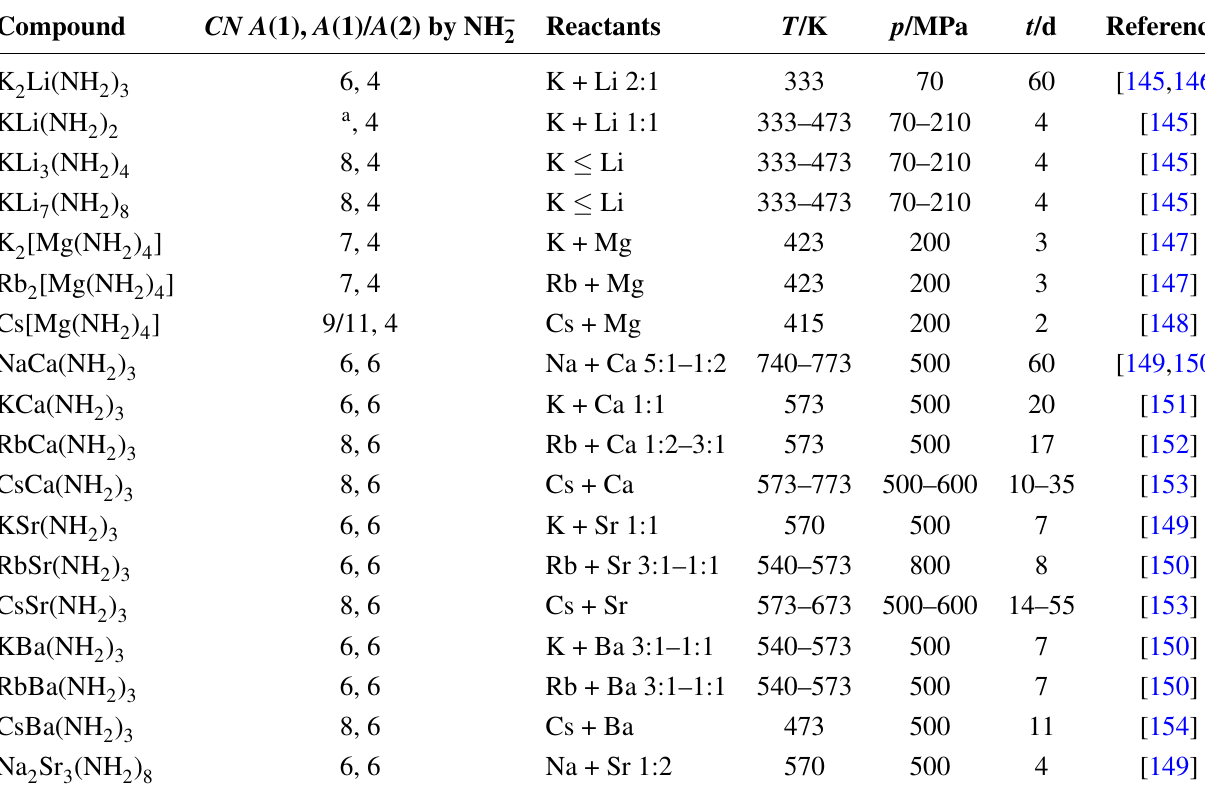
Table 5. Conditions for the ammonothermal synthesis of alkali metal alkaline-earth metal ternary amides and coordination numbers of the metal atoms by amide ions. Compound